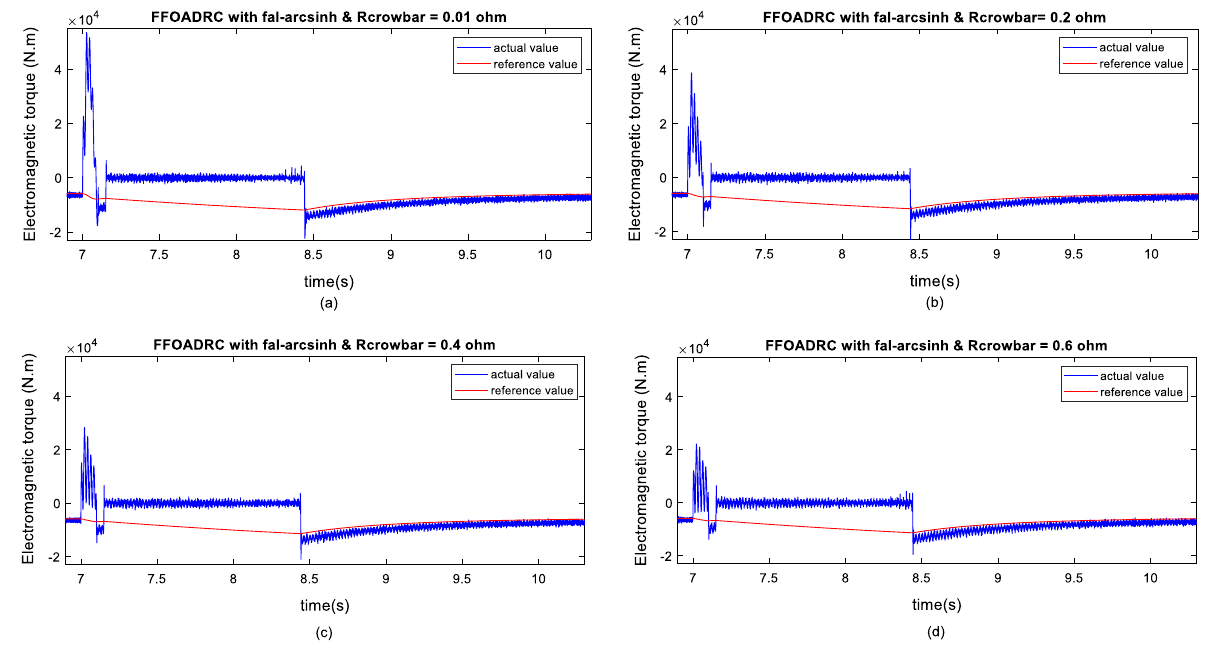
Fig. 30 Electromagnetic torque of the DFIG during symmetrical voltage swell for different values of R crowbar . ( a ) R crowbar ohm, ( c ) R crowbar 0.4 ohm, and ( d ) R crowbar =